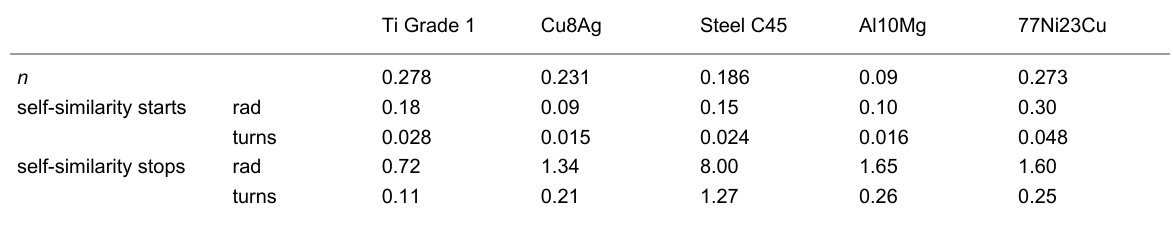
Table 3: Scaling ranges and their respective exponents.